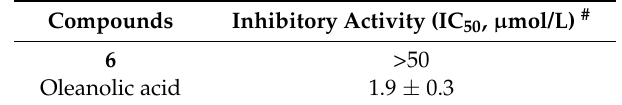
Table 2. Protein tyrosine phosphatase 1B (PTP1B) inhibitory activity of compound 6 .